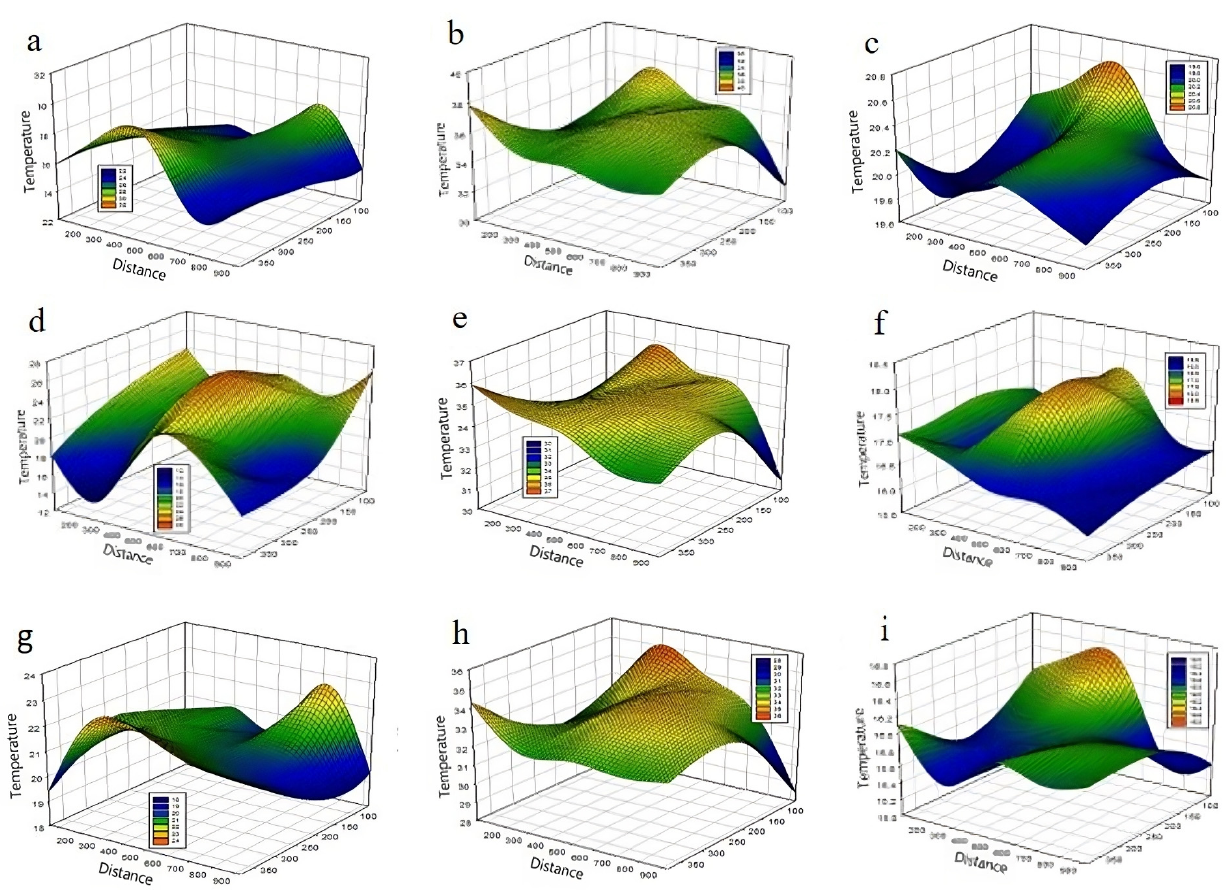
Figure 10. Changes in air temperature ( ◦ C) in upper location (in centimeters): ( a ) 10–11 a.m., ( b ) 2–3 p.m., ( c ) 5–6 p.m.; in middle location: ( d ) 10–11 a.m., ( e ) 2–3 p.m., ( f ) 5–6 p.m.; and in lower location: ( g ) 10–11 a.m., ( h ) 2–3 p.m., ( i ) 5–6 p.m. during the CS experimental periods.